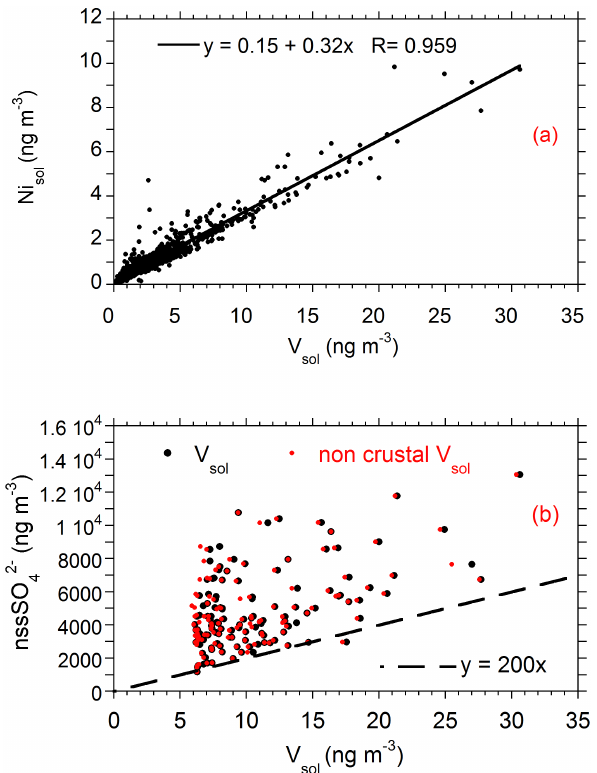
Fig. 4. Scatter plots Ni sol (a) and nssSO 2 − (b) vs. V sol . Line in 4 plot a represents the linear correlation, dashed line in (b) represents the ratio nssSO 2 − /V sol = 200. Red dots in (b) represent non crustal 4 V sol